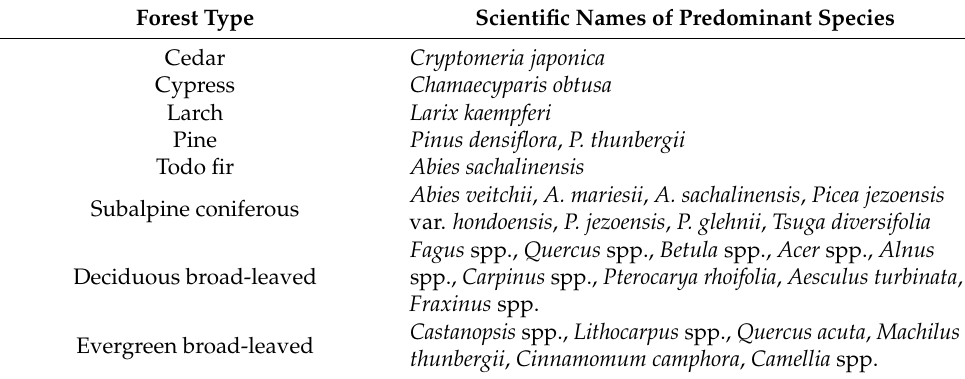
Table 1. Forest types and their predominant tree species in